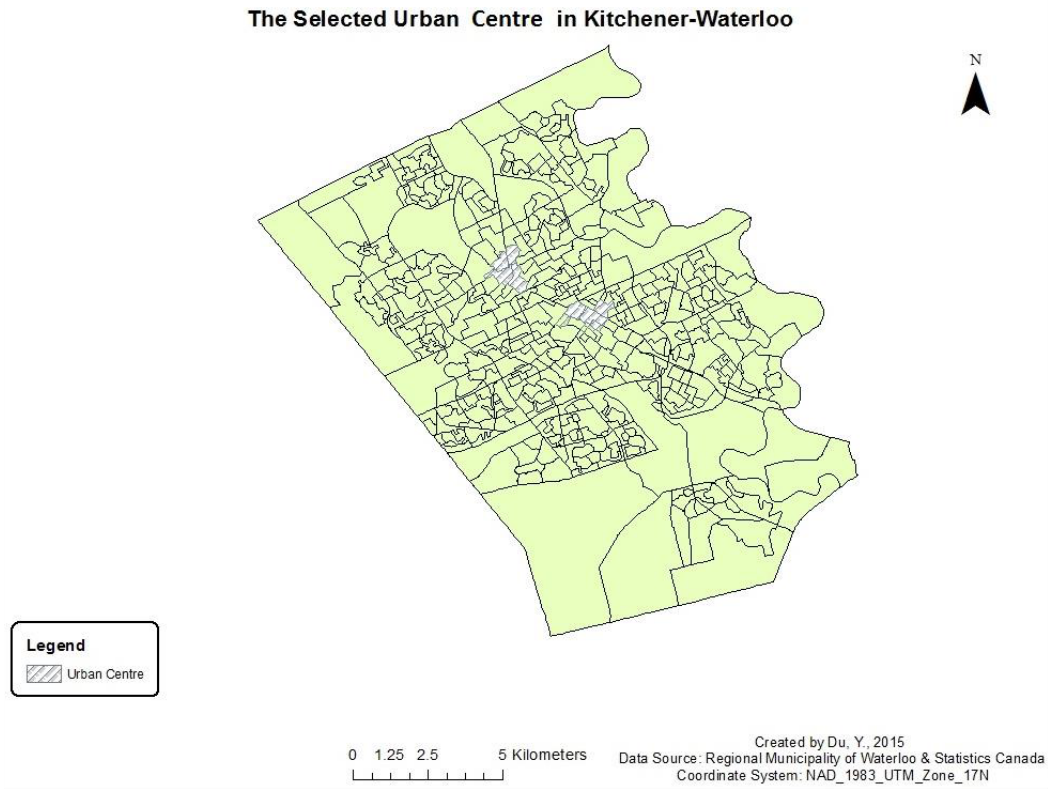
Figure 2. The Selected Urban Center in Kitchener-Waterloo.